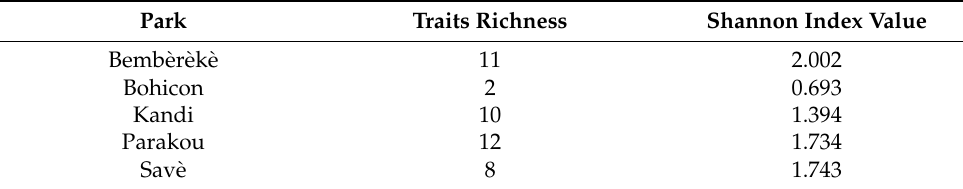
Table 3. Shannon index diversity and shea trait richness per